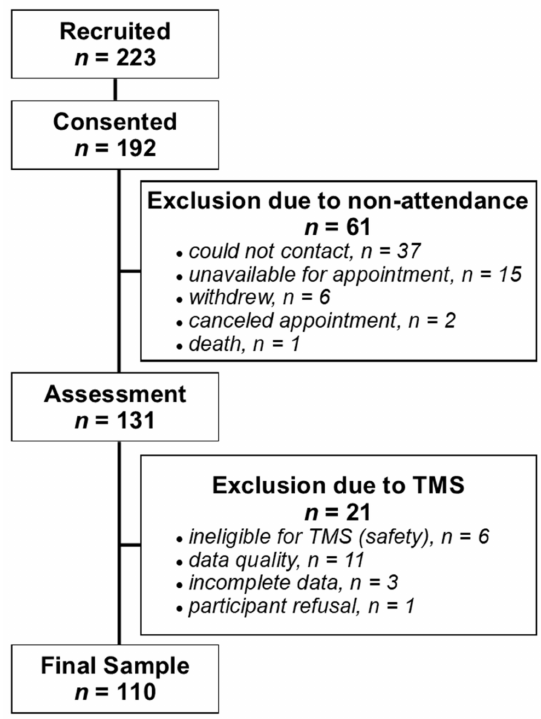
Figure 6. Recruitment of